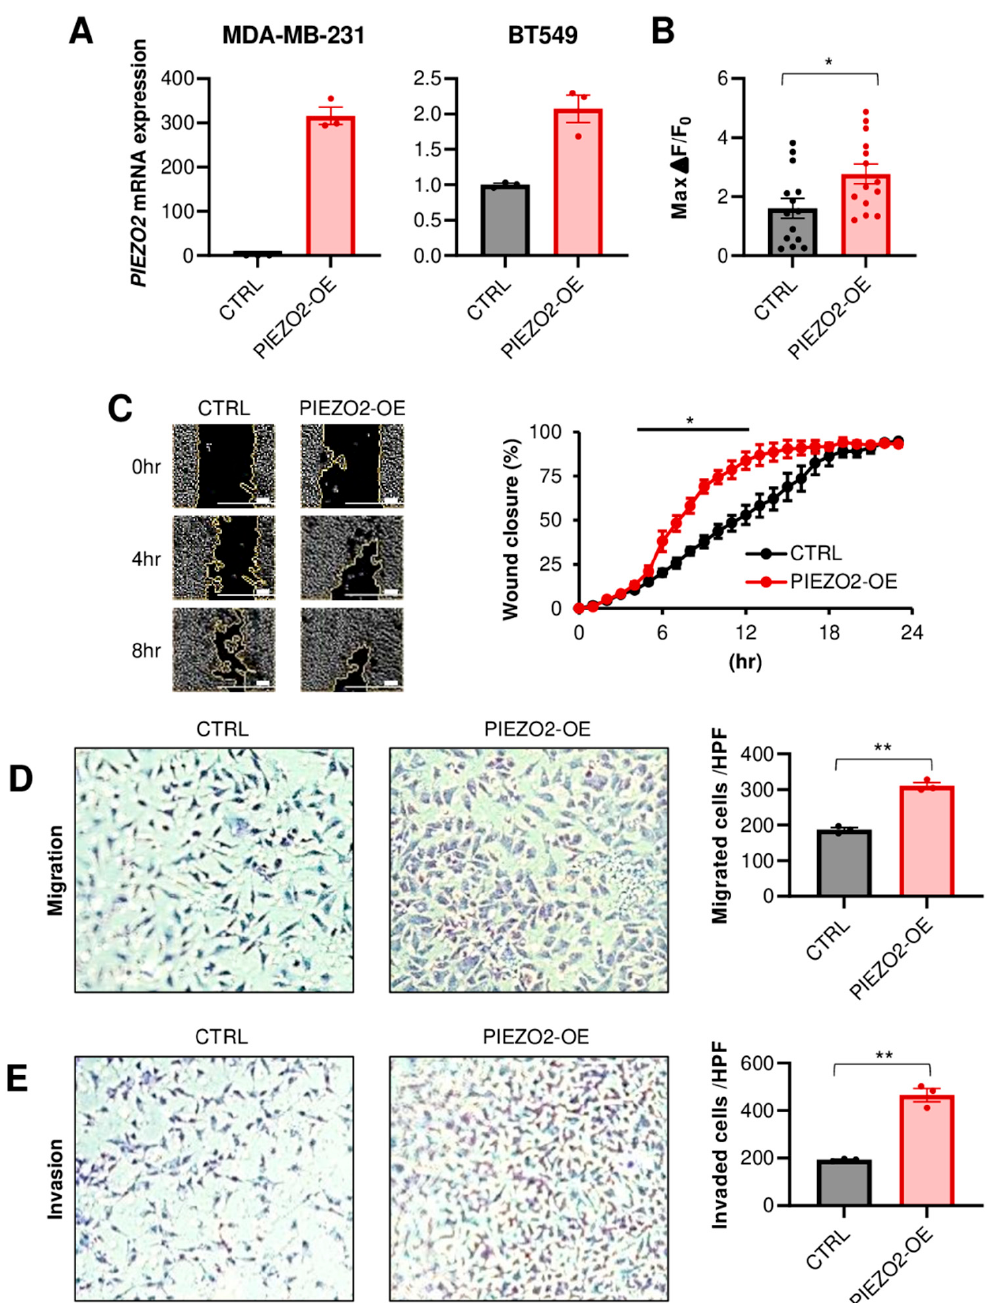
Figure 2. Overexpression of PIEZO2 leads to invasive phenotype in vitro . ( A ) PIEZO2 mRNA measured by qPCR in control (CTRL) or PIEZO2 inserted vector (PIEZO2-OE) transfected MDA-MB-231 and BT549 cells. ( B ) Changes in intracellular Ca 2+ after mechanical stimulation in control or PIEZO2 overexpressed MDA-MB-231 cells. n = 13, each. ( C ) Wound healing assay of control or PIEZO2 overexpressed MDA-MB-231 cells. The scale bar indicates 100 µ m. Transwell migration assay ( D ) and invasion assay ( E ) in control and PIEZO2 overexpressed MDA-MB-231 cells. * p < 0.05, ** p < 0.01.